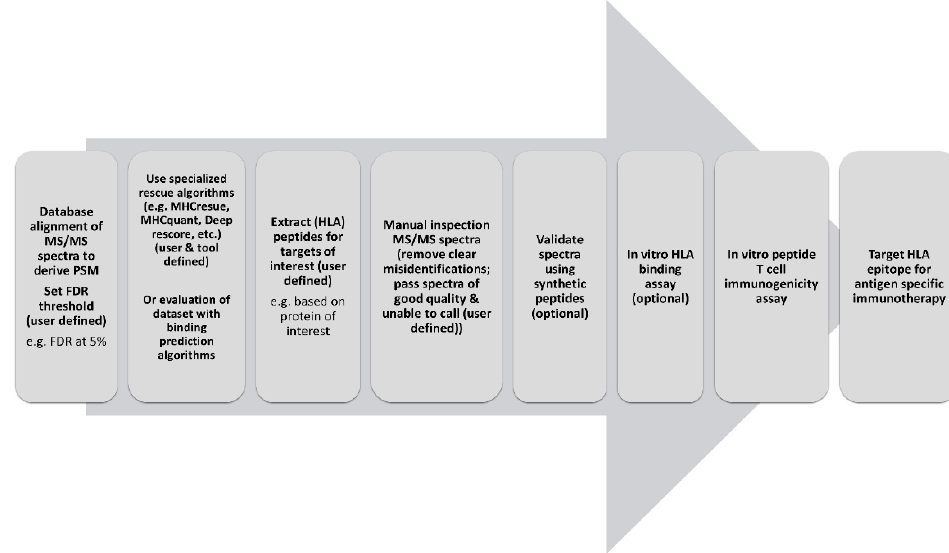
Figure 3. Proposed workflow regarding the use and handling of mass spectrometry data in the application and discovery of HLA-peptides to be used for antigen-specific immunotherapy.